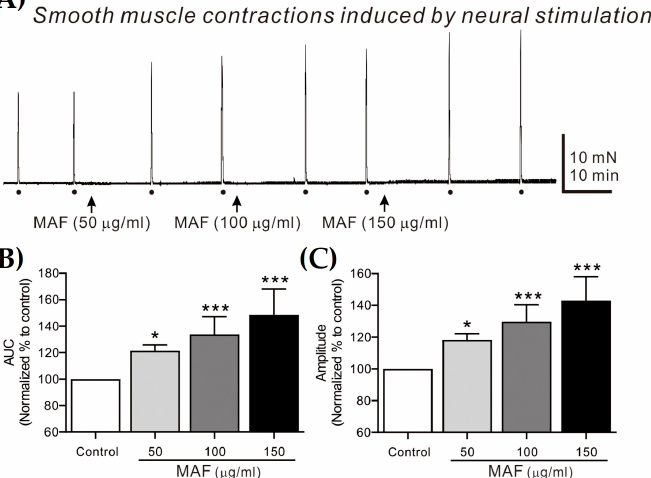
Figure 4. E ff ects of MAF on EFS-induced contractions of smooth muscle strips in human ileum in Figure 4. Effects of MAF on EFS-induced contractions of smooth muscle strips in human ileum situ. ( A ) Representative raw traces showing that MAF increased electrically evoked contractions by